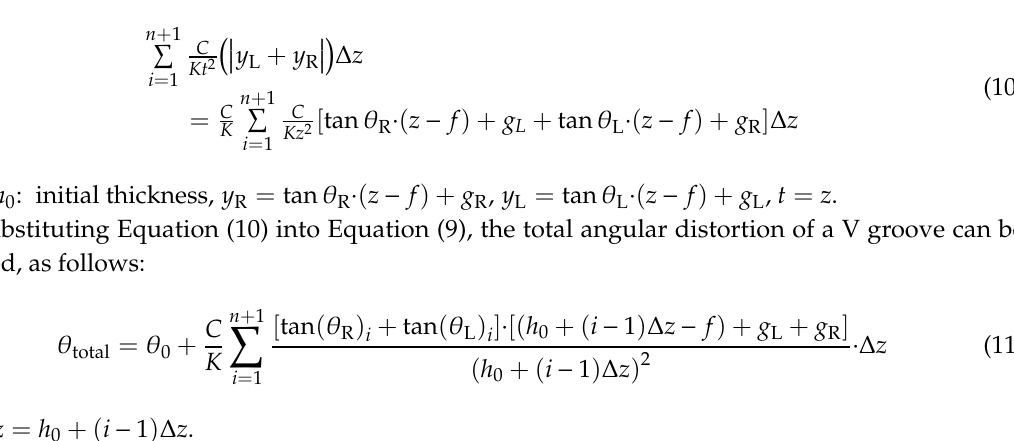
Figure 7. Geometry of V groove welding joint ( f : root face, g L , g R : left and right root gaps, respectively, h n : thickness of base metal, h 0 : initial thickness, θ L , θ R : left and right bevel angles, respectively).